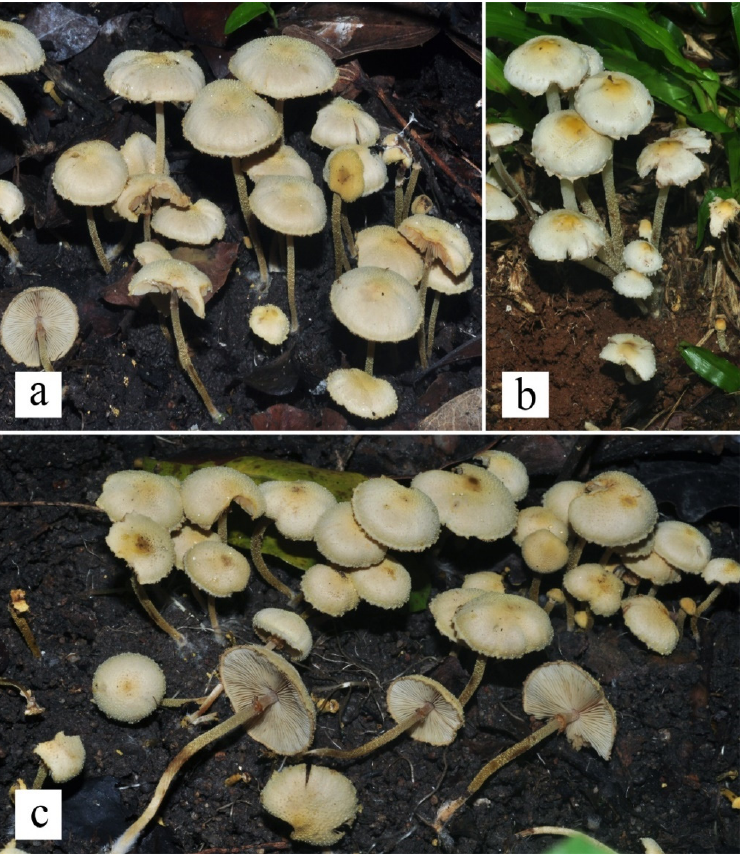
Figure 25. Basidiomata of Xanthagaricus necopinatus in situ. ( a ) MFLU 19-2353. ( b ) MFLU 19-2359. ( c ) MFLU 19-2358.